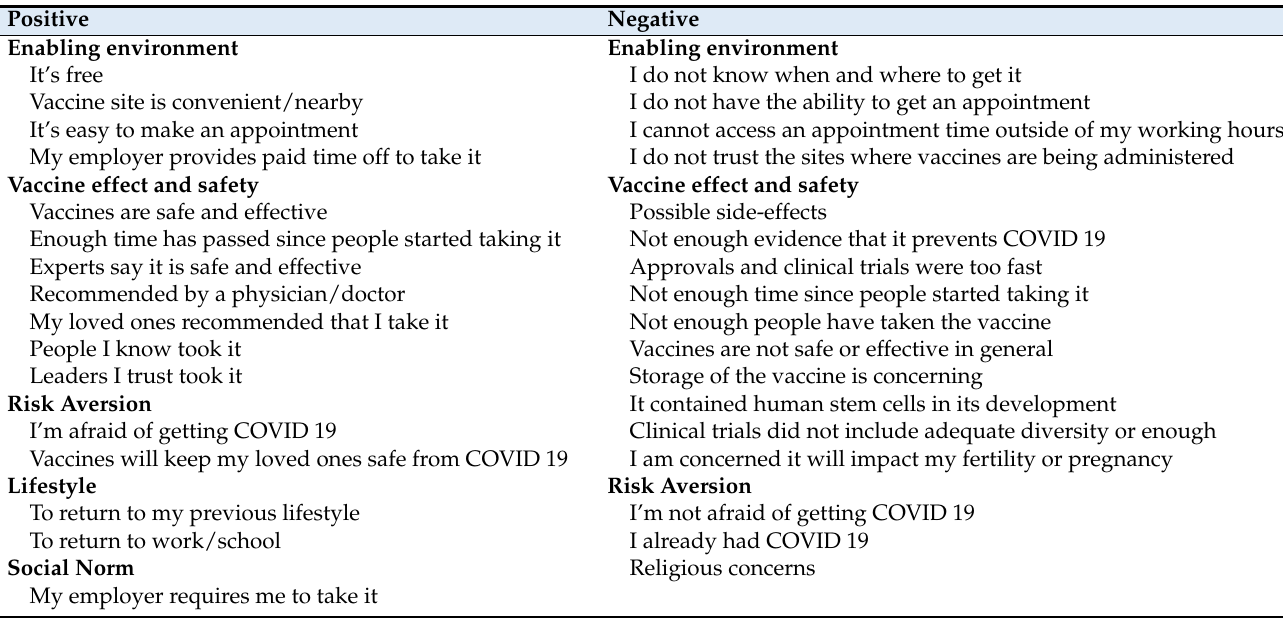
Table 2. Questions for reasons (factors) to receive